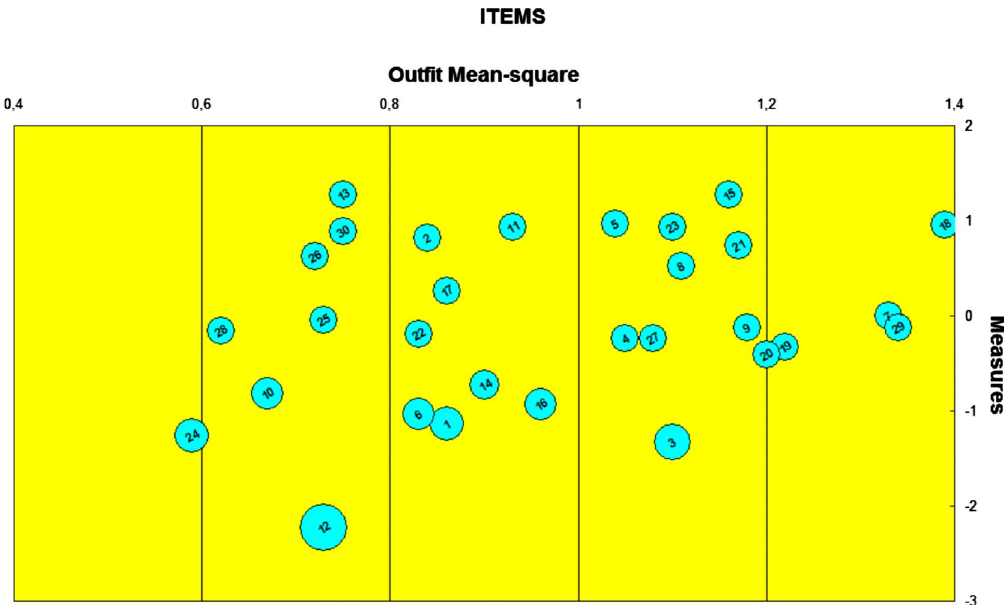
FIG. 6. (cid:1) Color (cid:2) The bubble chart for the university students showing outfit mean square statistics (cid:1) MNSQ (cid:2) vs item